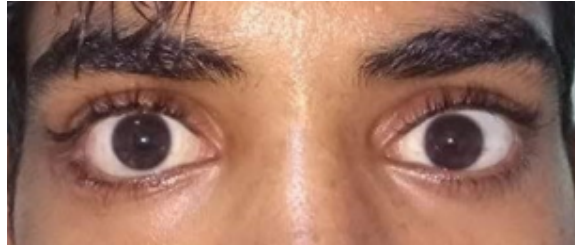
Figure 5: Postoperative photograph after 4